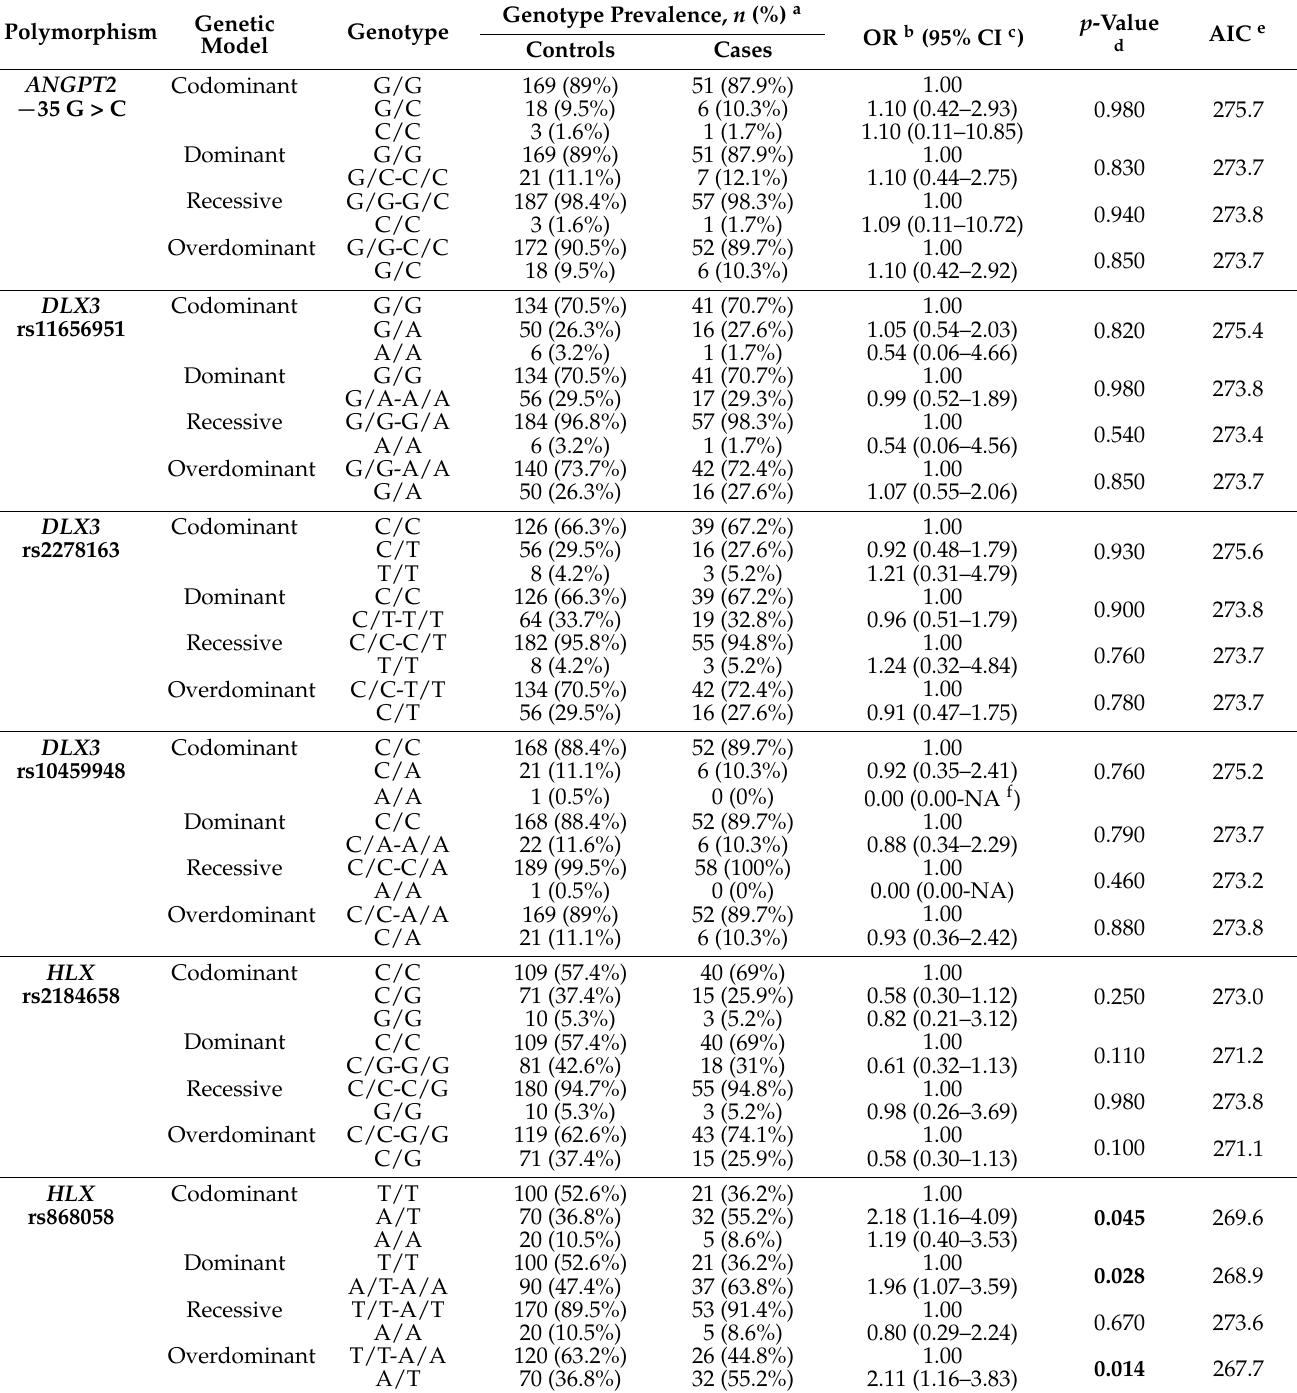
Table 2. Relationships among the polymorphisms in ANGPT2 , DLX3 , HLX , and ITGAV genes, and the early-onset fetal growth